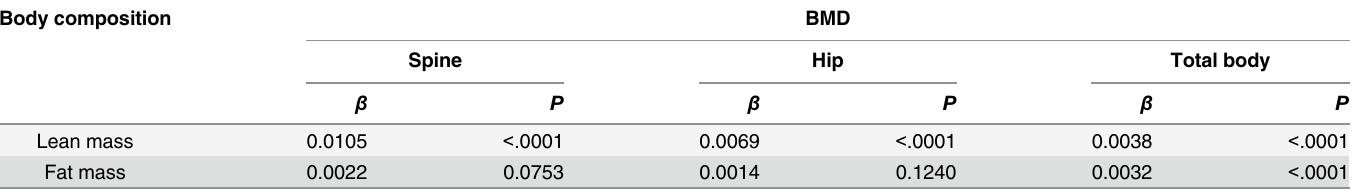
Table 4. The results from linear mixed model of lean mass and fat mass on BMD of the spine, hip, and the total body: 2-year follow-up data. Body composition